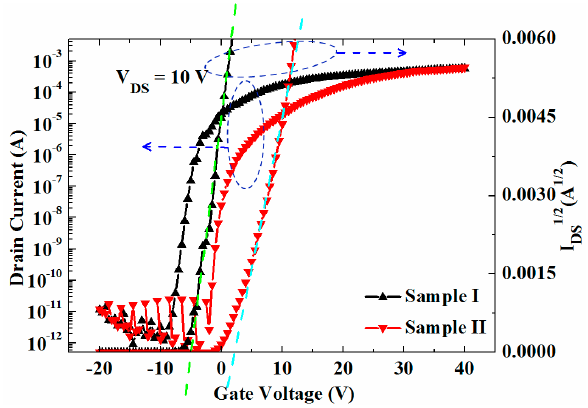
Figure 4. Transfer curves of the N-doped DSCL TFTs (Samples I (a-IGZO:N/a-IZO:N TFT) and II (a-IZO:N/a-IGZO:N TFT)).